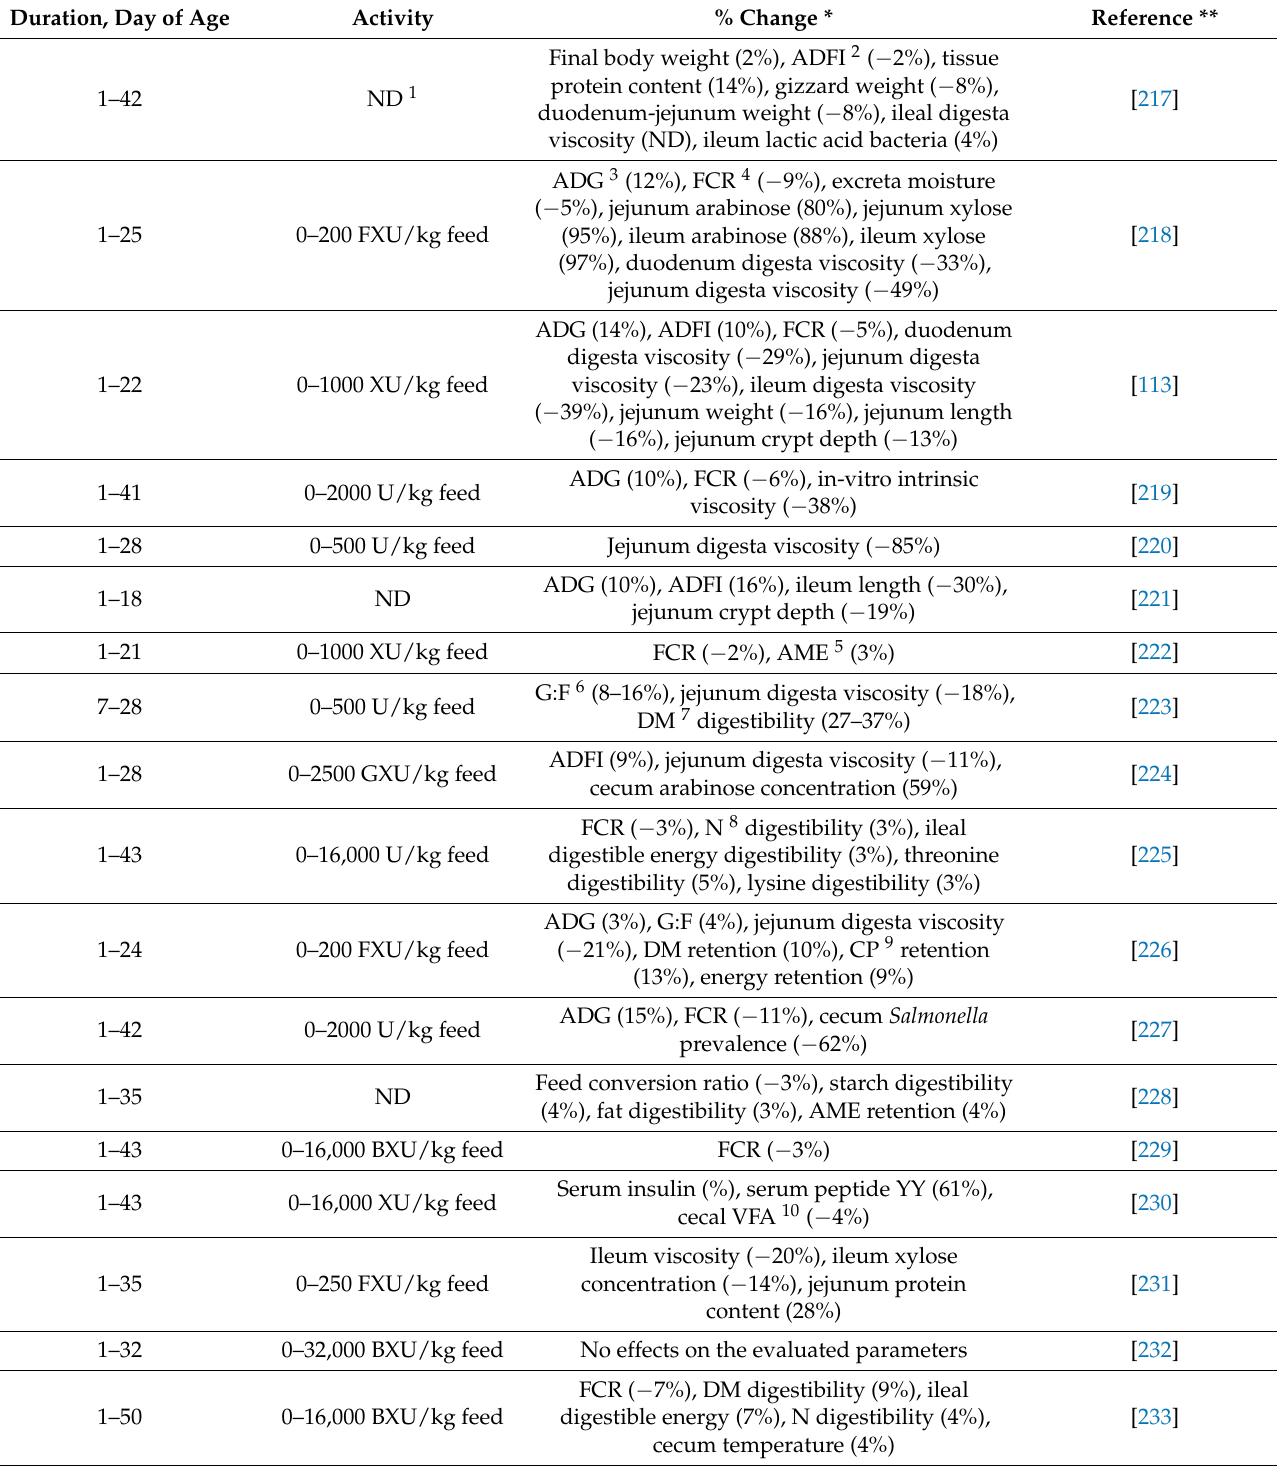
Table 3. A list of studies describing effects of xylanase supplemented individually at different levels in diets for broiler